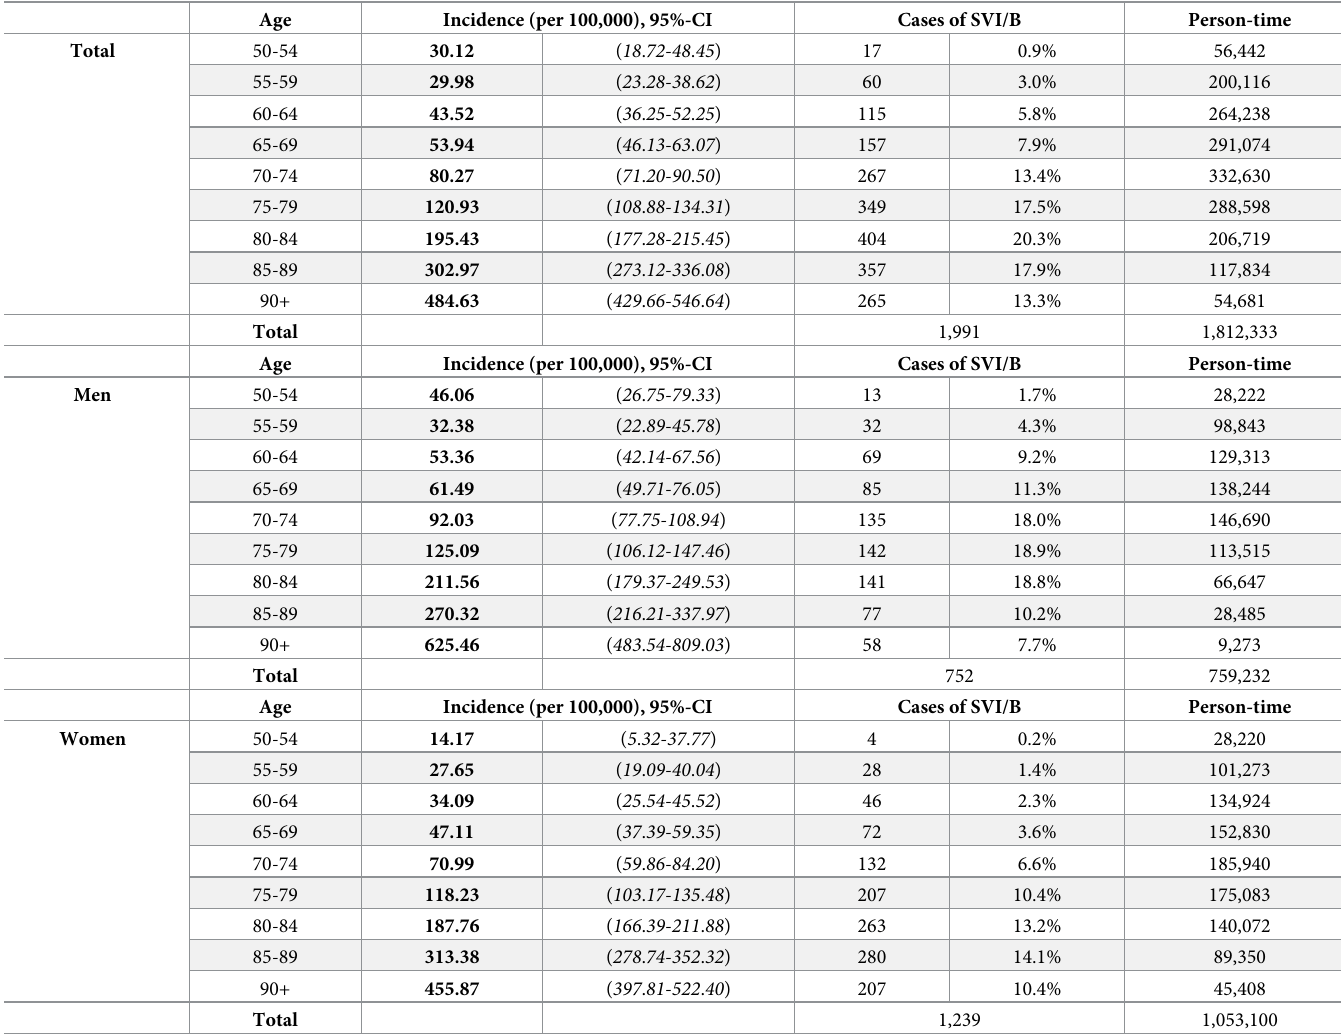
Table 1. Incidence of SVI/B (Sample I) by sex and age at incidence, 2006-2015, AOK